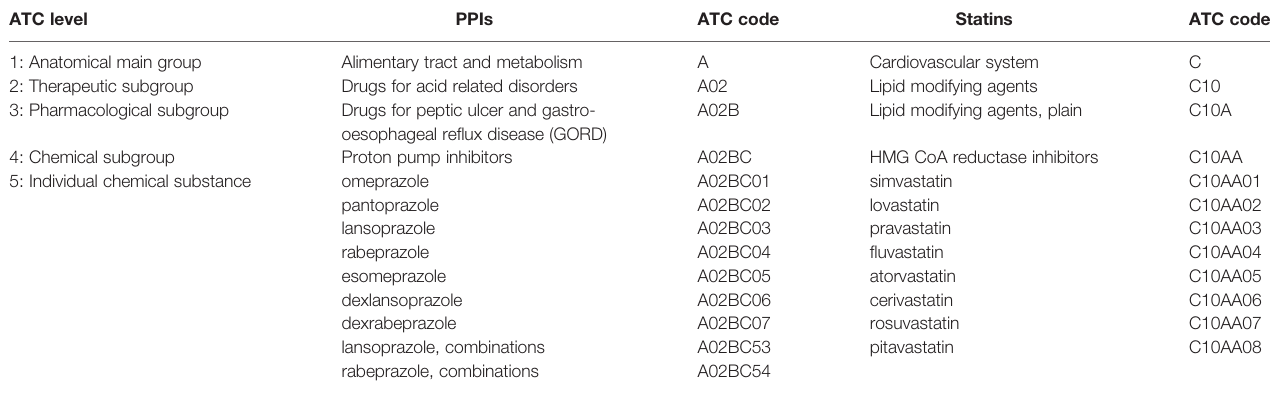
TABLE 2 | ATC classi fi cation structures for proton pump inhibitors and statins. ATC